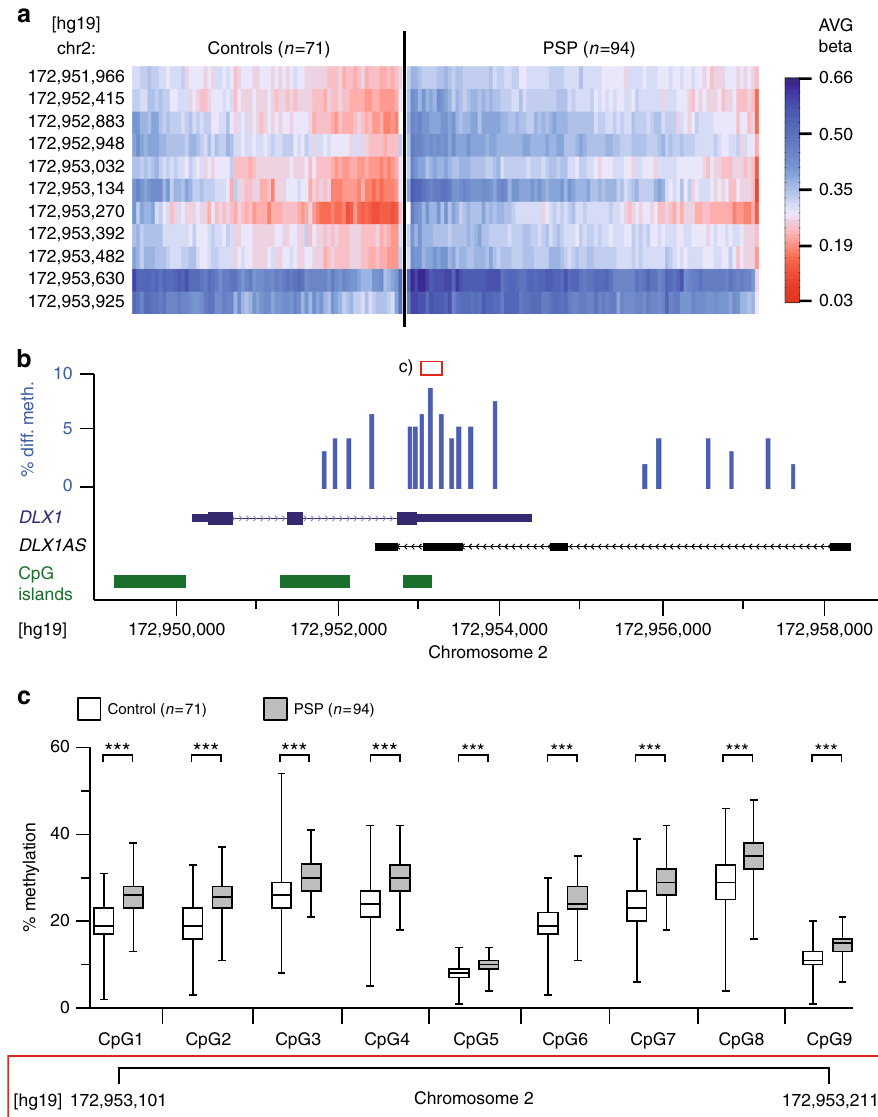
Fig. 3 Methylation status of DLX1 . a Heat-map showing degree of individual methylation at various genomic sites within DLX1 on chromosome 2 (chr2) in forebrains of n = 94 PSP patients vs. n = 71 controls. Average (AVG) beta indicates the color-coded methylation value (1.00 equals 100%, Genome Studio Software Version 2011.1, Illumina, San Diego, CA). b DLX1 is composed of three alternatively spliced exons (dark blue). DLX1 antisense transcript ( DLX1AS ) is encoded by at least four alternatively spliced exons (black). The location of CpG islands relative to DLX1 and DLX1AS is shown according to the UCSC genome browser data (green). The percentage difference in methylation in PSP as compared to controls at various sites within DLX1 and DLX1AS is shown as bar chart (blue). c Pyrosequencing con fi rmed the differential methylation at nine CpGs within the CpG island of the 3´UTR of DLX1 [red boxes in b and c indicate corresponding genomic regions; *** P < 0.001, Welch´s corrected unpaired t -test]. The line in the middle of the box and whisker graph represents the median (50th percentile). The box extends from the 25th to 75th percentile. The whiskers extend from the lowest to the highest